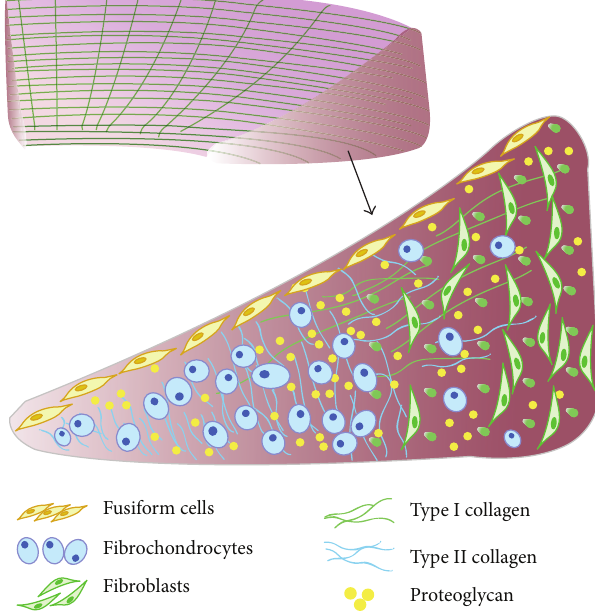
Figure 1: Schematic diagram of meniscus internal ultrastructure. Most of collagen fibers bundles oriented circumferentially; only few of them presented a radial alignment. Cells of the superficial zone are fusiform in shape and located below the tissue surface; the cells in the outer one-third region or vascular zone are mainly elongated fibroblasts, and collagen I accounts for > 90%; for inner two-thirds region or avascular zone, round or oval shaped fibrochondrocytes are interspersed, the ratio of collagen I and collagen II is about 2: